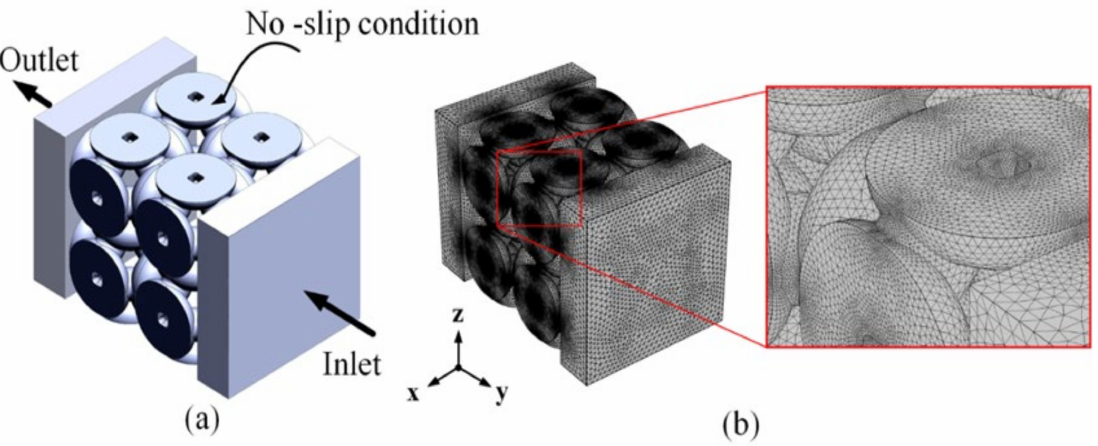
Figure 3. The steps used to characterize the fluid dynamics of the scaffold: ( a ) The simulation’s boundary condition; ( b ) a suitable convergent meshing model can be